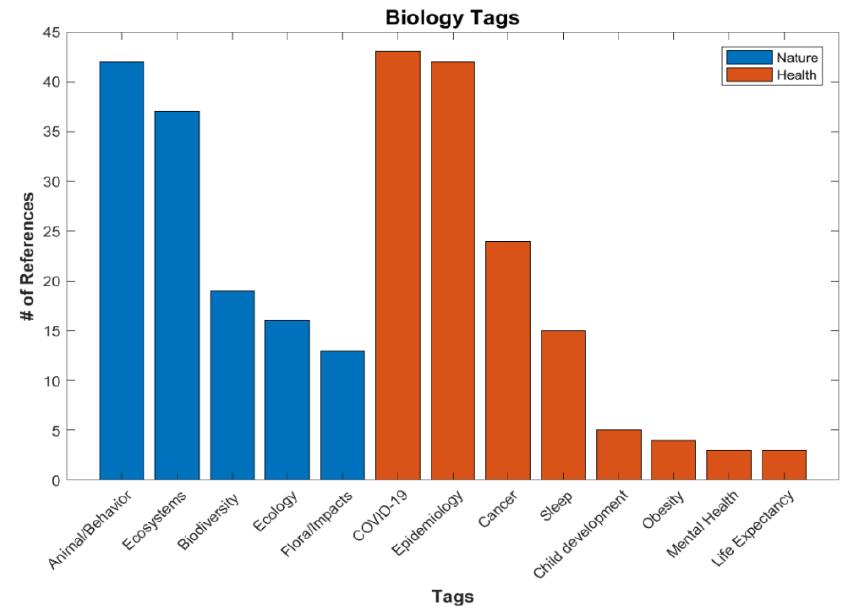
Figure 11. Number of references for various tags under Applications/Biology.